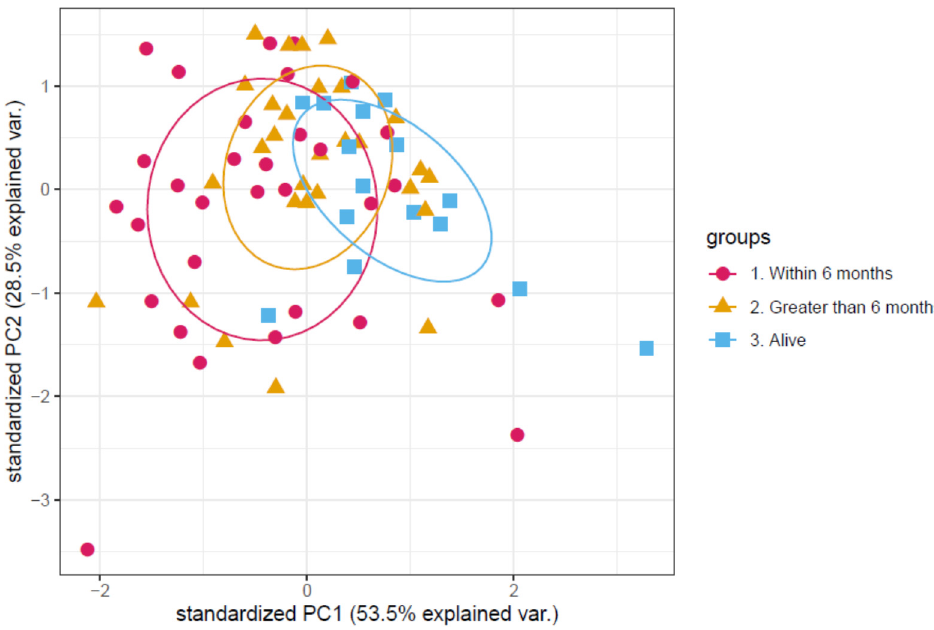
Figure 3. Principal component analysis of the protein abundance levels of the validation set. Each point in the principal component analysis is an individual patient sample. Patients are colour coded according to the patient’s survival time after samples were taken. With those still alive as of publication coloured in blue, those who survived longer than 6 months coloured in orange and those who died within 6 months coloured in magenta. There is a slight separation visible between those that died within 6 months and those that died after 6 months.